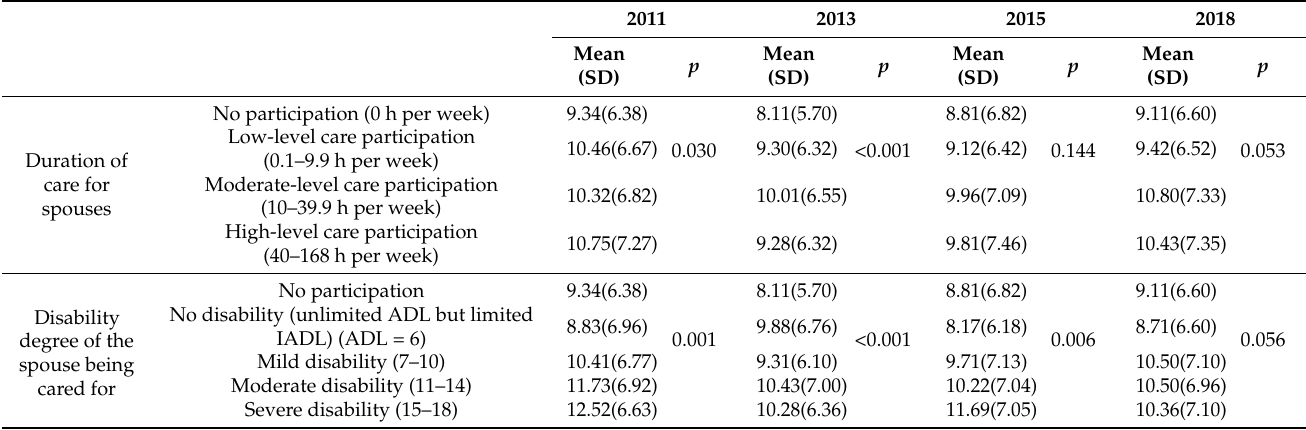
Table 3. Depression levels of the older caregivers at different spousal caregiving intensities and disability degree from 2011 to